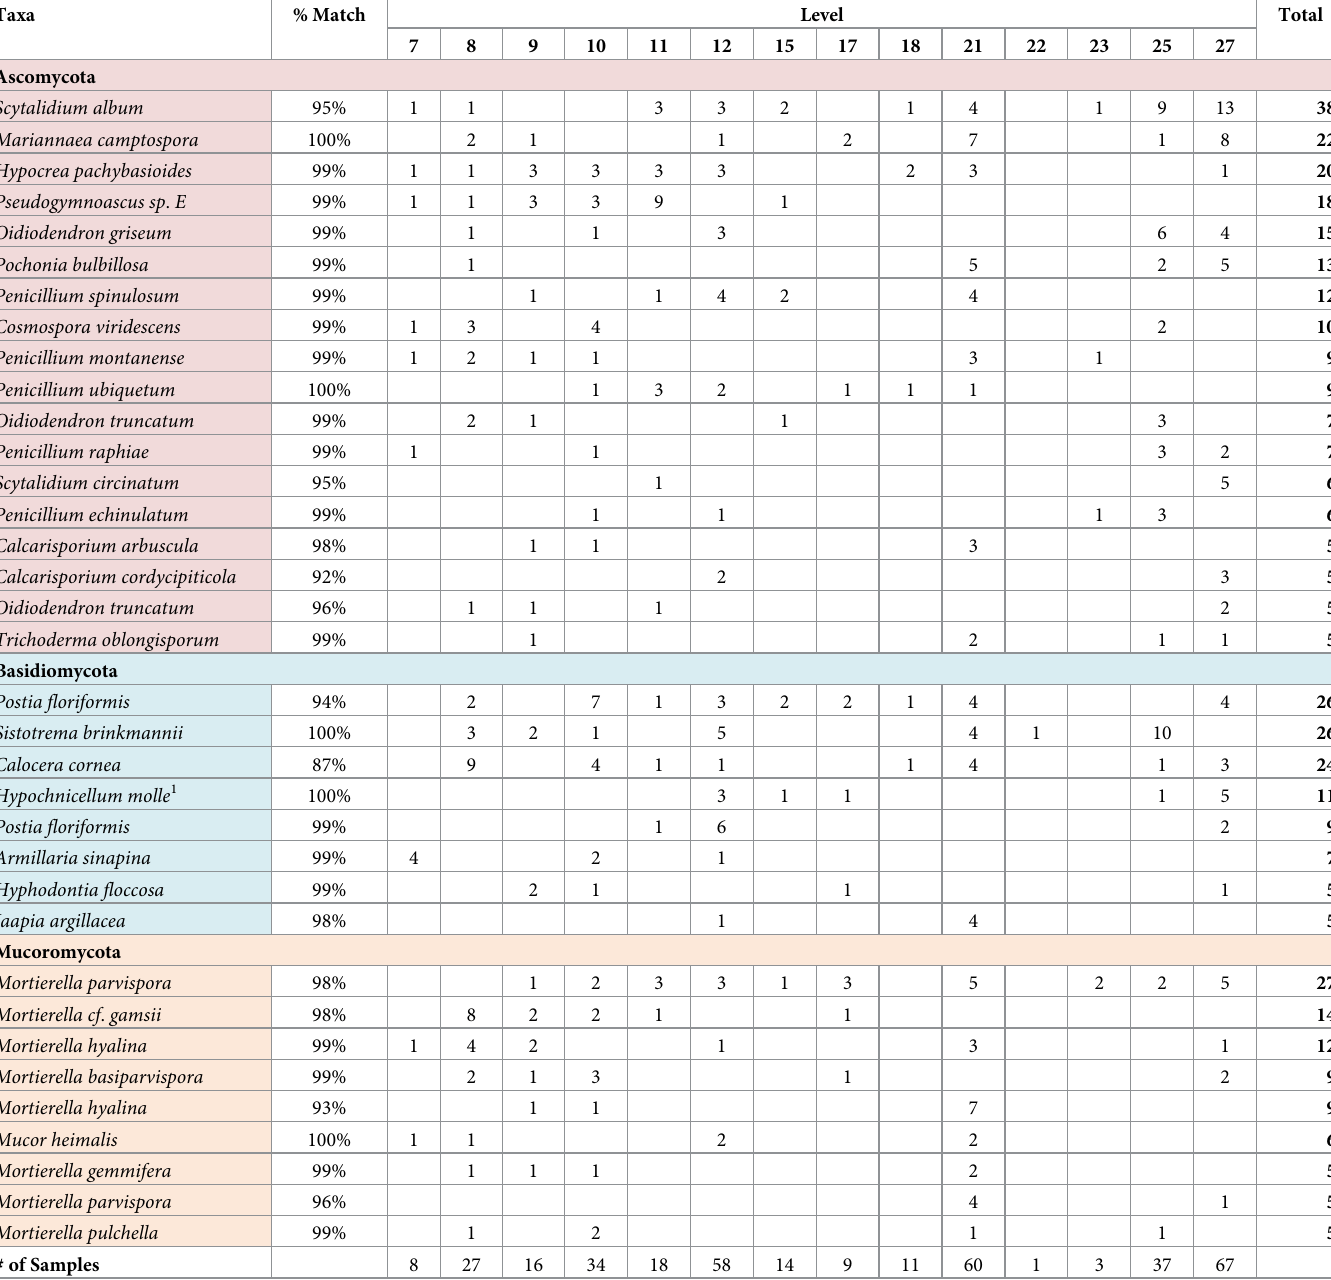
Table 1. List of fungal taxa, the best BLAST match and frequency isolated at specific levels of the Soudan mine. Fungi isolated 5 times or more are listed. S1 Table lists all fungi isolated and GenBank accession numbers. Taxa appearing more than once indicate different strains with different % BLAST